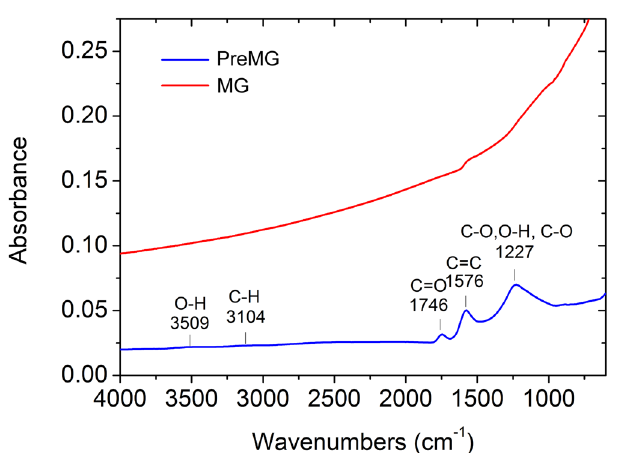
Figure 7. ATR-FTIR characterization of PreMG and MG.